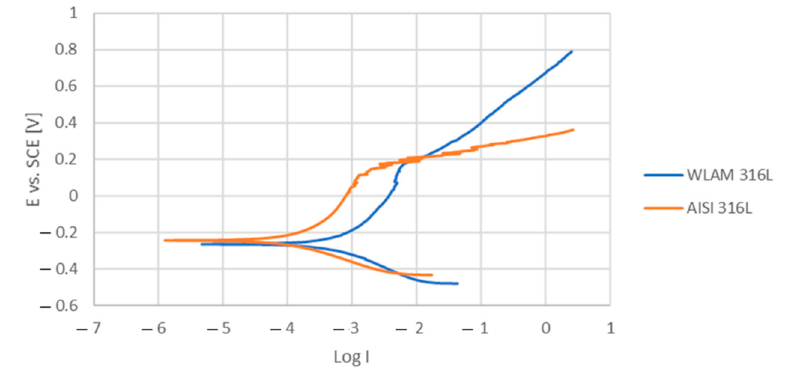
Figure 6. Potentiodynamic polarization curves of a WLAM sample and its counterpart AISI 316L alloy. Table 4. Corrosion characteristics of the WLAM sample and its counterpart AISI 316L alloy, along with corrosion rate measurements obtained by Tafel extrapolation.